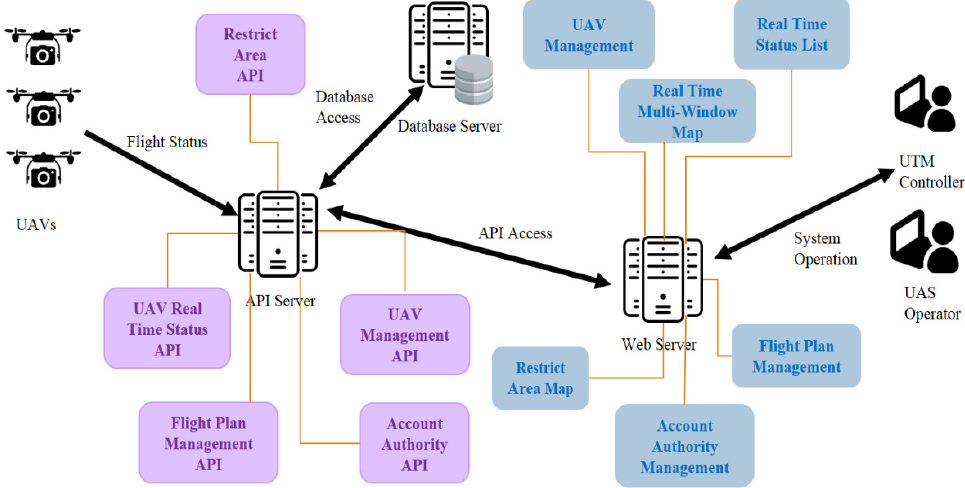
Figure 5. The proposed hierarchical UTM system.